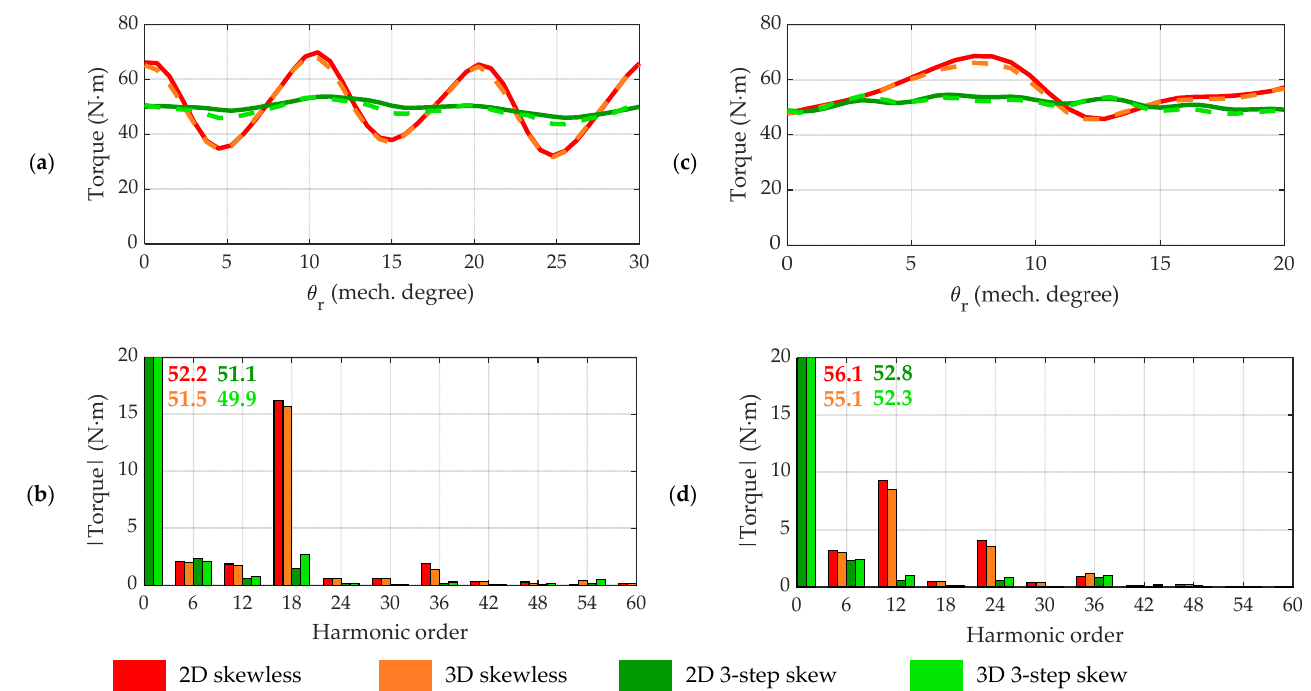
Figure 7. Comparison of electromagnetic torque waveform and harmonic content of skewless machine vs. three-step skewed machine: ( a ) torque waveform of four-pole machine with two barriers per pole; ( b ) torque spatial harmonic content of four-pole machine with two barriers per pole; ( c ) torque waveform of six-pole machine with two barriers per pole; ( d ) torque spatial harmonic content of six-pole machine with two barriers per pole. The 2D and 3D simulation results are compared.